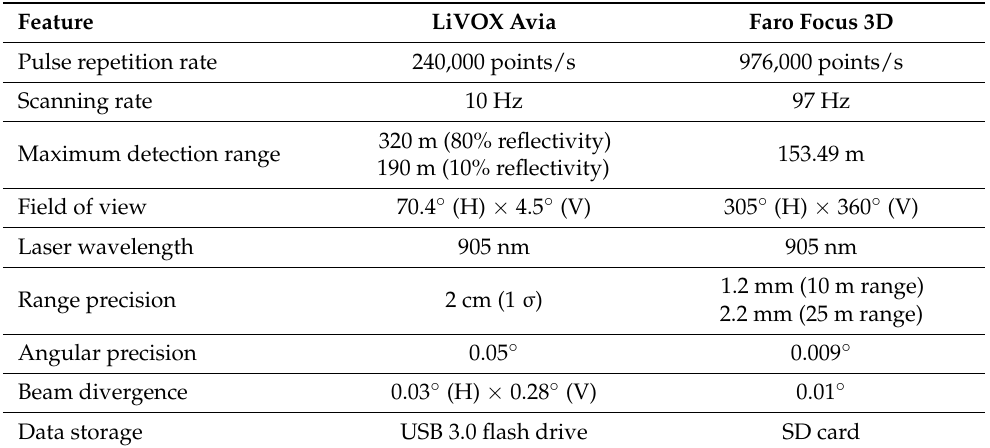
Figure 1. Infrastructure used for the validation of the solid-state LiDAR system. The LiVOX Avia (blue) and navigation system (red) are highlighted. Table 1. Technical specifications of the LiVOX Avia and Faro Focus